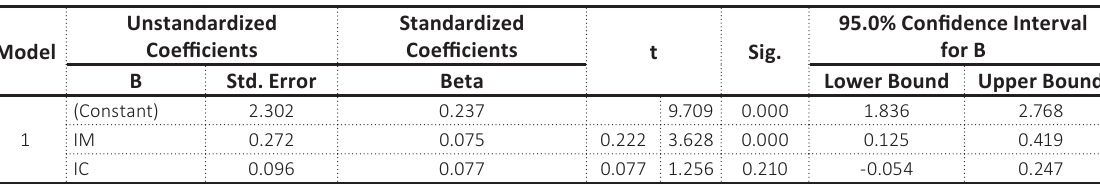
Table 12. Coefficients a for H